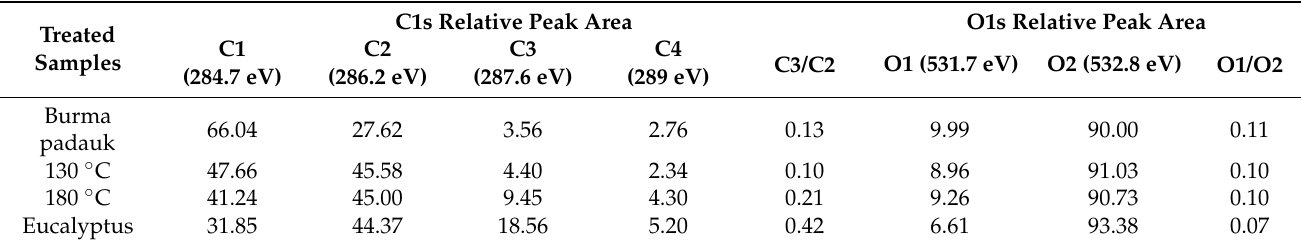
Table 2. Subpeak area fractions of C 1S and O 1S in XPS spectra.